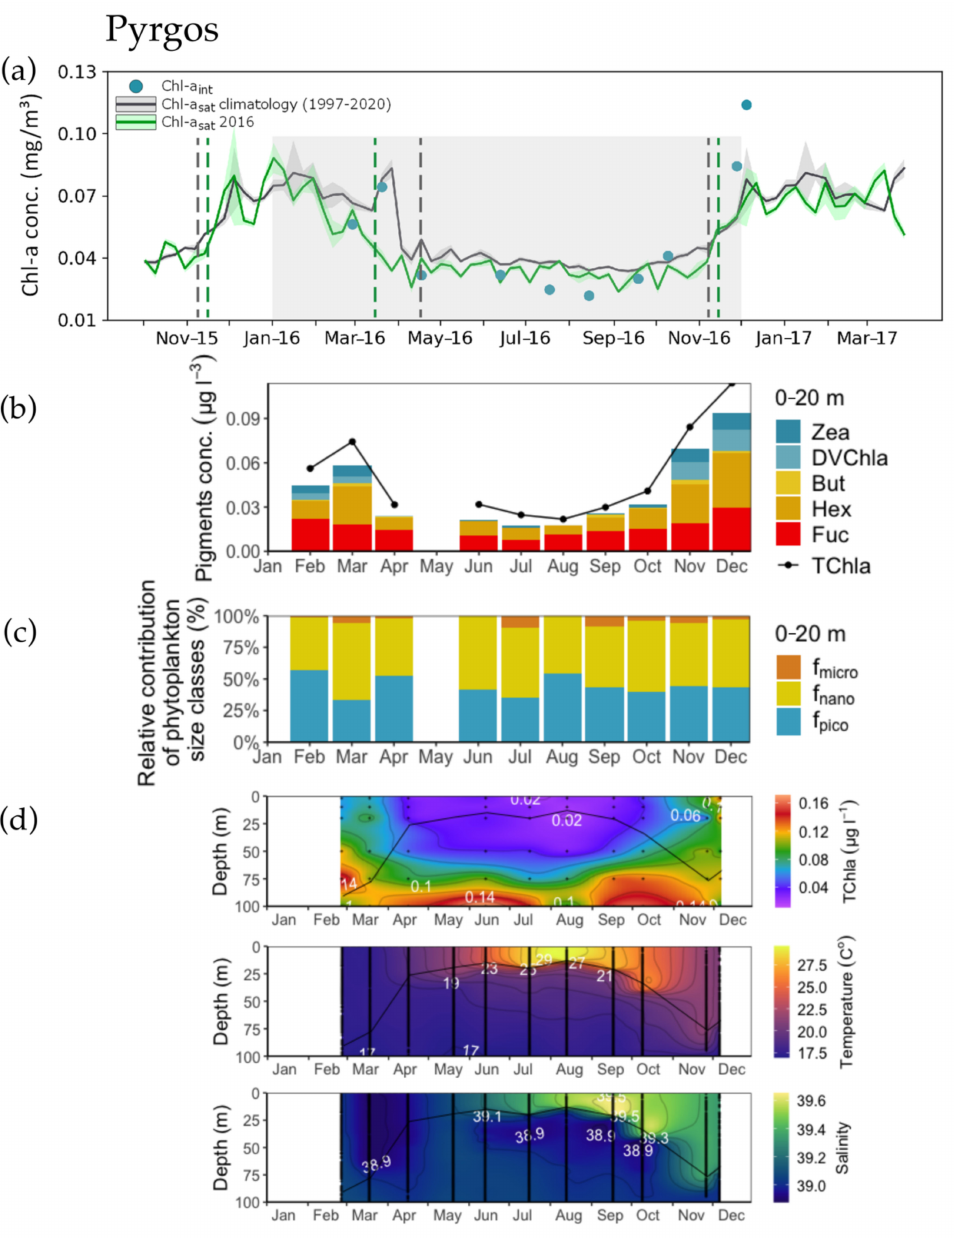
Figure 2. Time series of satellite-derived Chl-a consecrations, diagnostic pigment concentrations and vertical profiles of total Chl-a, temperature and salinity in Pyrgos (PYR) station. ( a ) Climatology time-series (based on 23-year OC-CNR data of daily composites) (Chl-a sat climatology (1997–2020) in comparison with satellite-derived Chl-a concentration from October 2015 to March 2017 (Chl-a sat 2016). Blue dots represent the in situ measurements (Chl-a int ) taken between January and December 2016 (shaded area). The dashed lines represent the timing of initiation and termination of the main phytoplankton growth, ( b ) Diagnostic pigments concentrations for the 0–20 m layer, ( c ) Percentages associated with the pico- (fpico), nano- (fnano) and micro-phytoplankton (fmicro) size classes, for the 0–20 m layer, ( d ) Vertical profiles of CTD temperature, salinity, and HPLC total Chl-a concentration. The black line represents the Mixed-Layer Depth (MLD). Note: The in situ data are a snapshot (one day in each month) compared to the weekly averages of the satellite retrieved